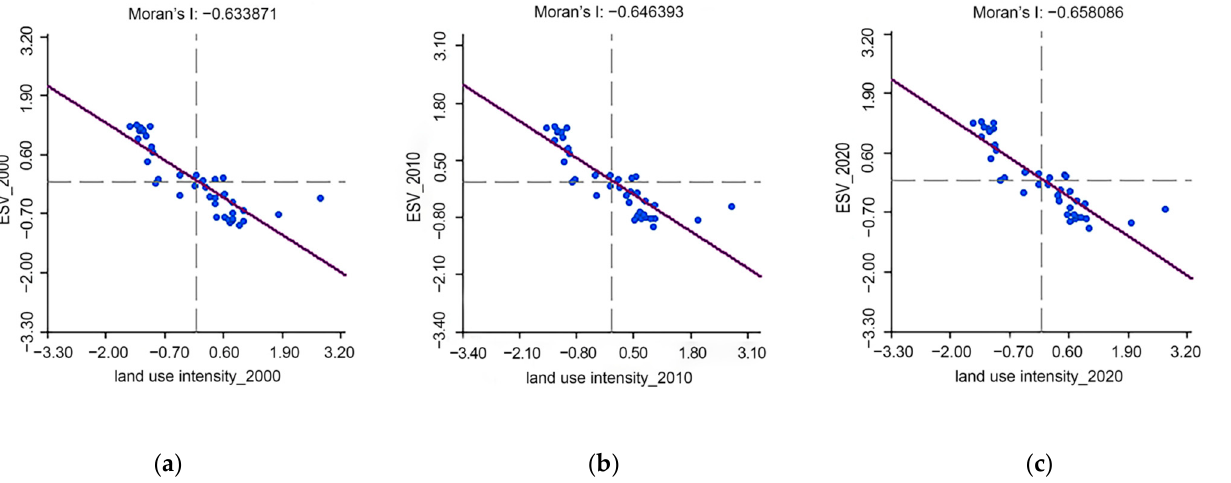
Figure 7. Moran scatter plots of land use intensity with ESV in the HRB of Hubei Province for ( a ) 2000, ( b ) 2010, and ( c ) 2020.